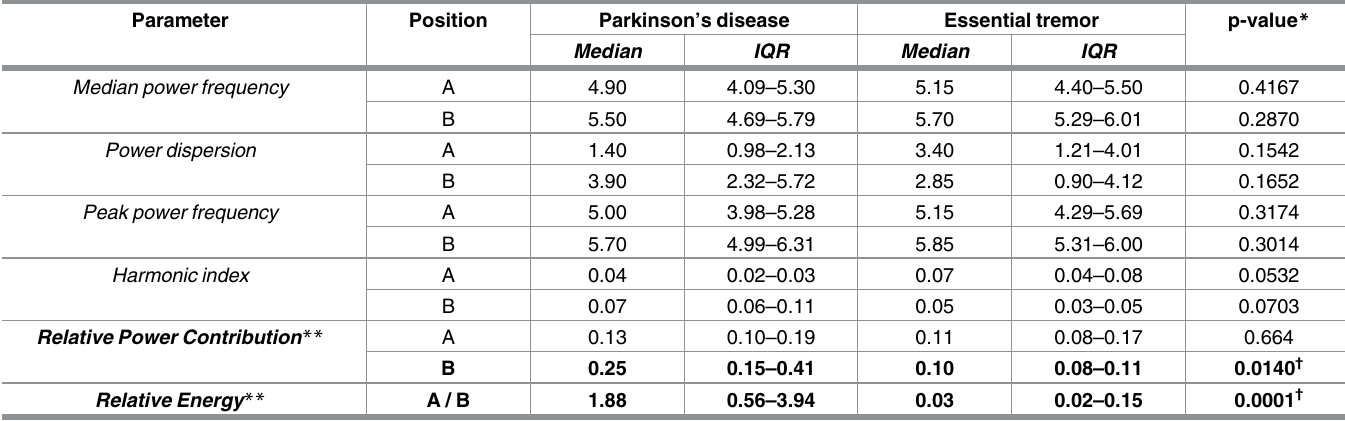
Table 3. Kinematic featuresof the spectral power analysis for rest and postural tremor in Parkinson’s disease and essential tremor subjects.